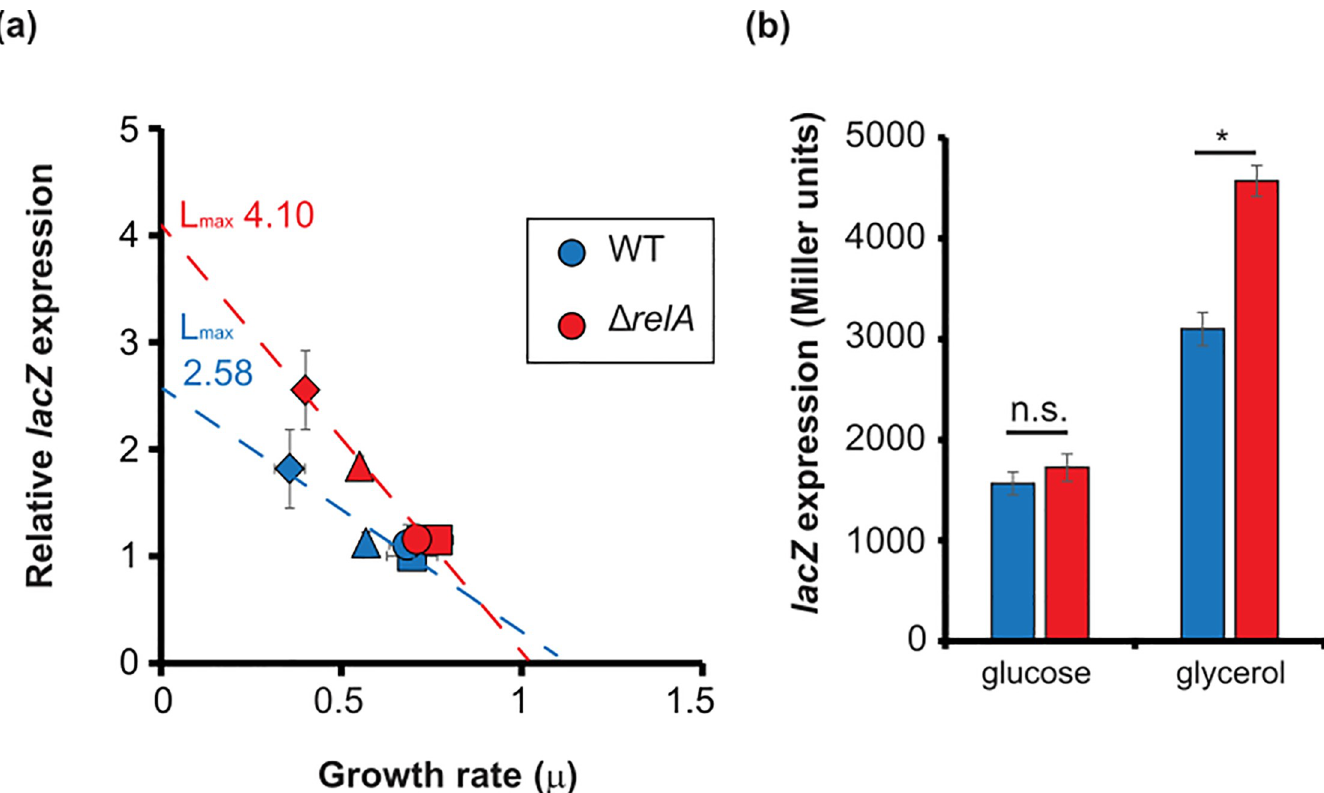
Fig 1. ppGpp affects lacZ expression dependent on growth rate. MG1655 (WT) and CF18005 ( Δ relA ) were grown up to exponential phase (OD 600 of 0.1) in M9 minimal media supplemented with glucose (squares), glycerol (diamonds), lactose (triangles) and NAG (circles). The lacZ expression was measured from 2 biological replicates and 3 technical replicates. The levels of lacZ expression levels were normalized to the expression of WT strain in M9 with glucose. Error bars represent SD. Lmax was calculated as in [36].